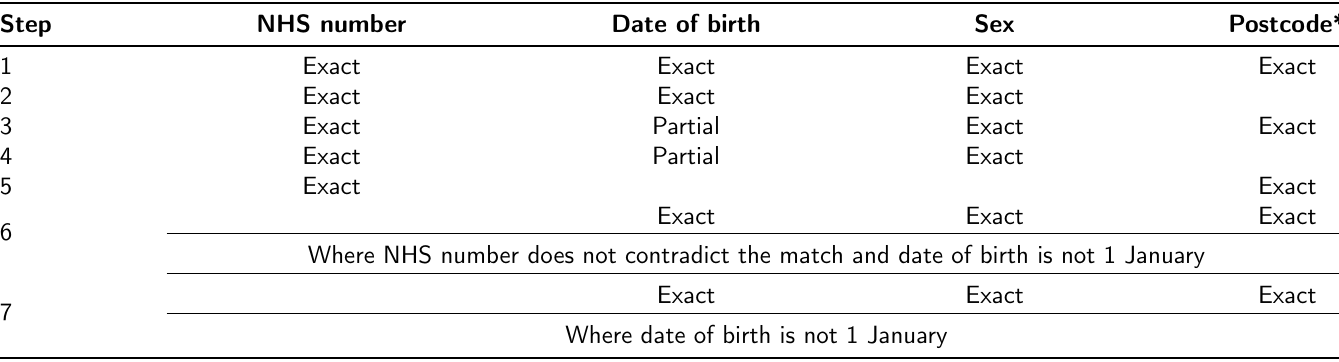
Table 3: Linkage stage 2: 7 step deterministic algorithm for linking the personal demographic service to hospital episode statistics